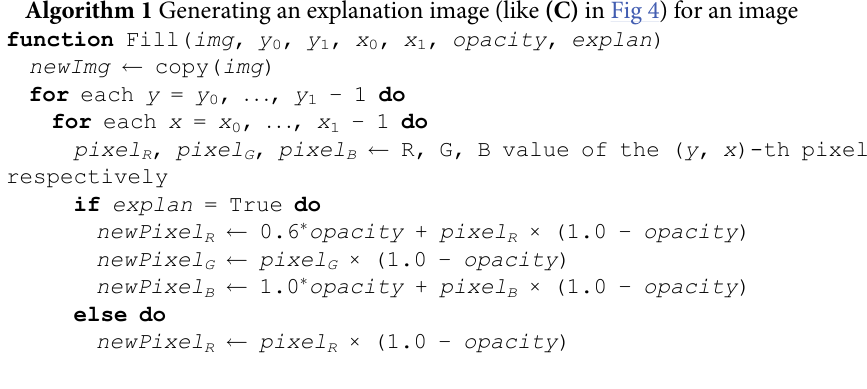
Algorithm 1 . In Algorithm 1 , function grayscale( img ) receives an image img , then performs gray-scaling to img , and returns the gray-scaled image. In addition, function predict( img , model , i ) receives an input image img , a convolutional neural network model model , and the layer index i = 0, . . . , layers − 1 where layers is the number of layers in model , including the input layer whose index i is 0 and output layer whose index i is layers − 1. For the layer index i , when the output of a layer whose index is i and the output is used for the input of the next out layer whose index is i , it is always true that i < i . function Fill( img , y , y , x , x , opacity , 0 1 0 1 in out in explan ) receives original image img and integer values y 0 , y 1 , x 0 , x 1 , then copies img and fills the square area of copied image with black (RGB 0,0,0) (when explan = False) or purple (RGB 153,0,255) (when explan = True) with opacity opacity whose range is 0.0 to 1.0 (when explan = False) or 0.75 (when explan = True), where the horizontal and vertical range of the area are from x to x ( x < x ) and from y to y ( y < y ), respectively. 0 1 0 1 0 1 0 1 Algorithm 1 Generating an explanation image (like (C) in Fig 4) for an image